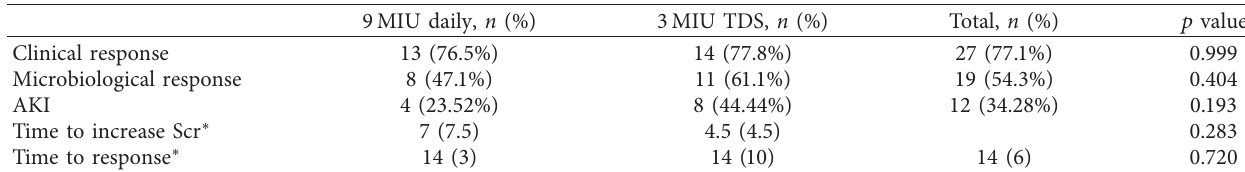
Table 2: Clinical and microbiological response and toxicity